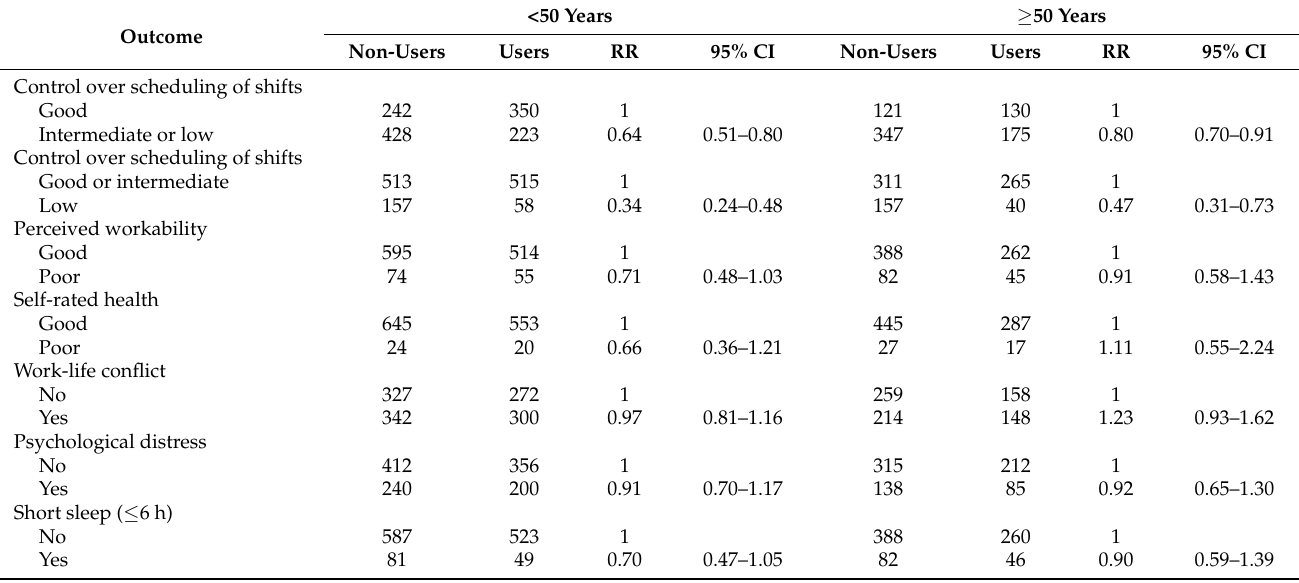
Table A2. Effects of using participatory working time scheduling software on the outcomes using subgroup balancing propensity score. RR, risk